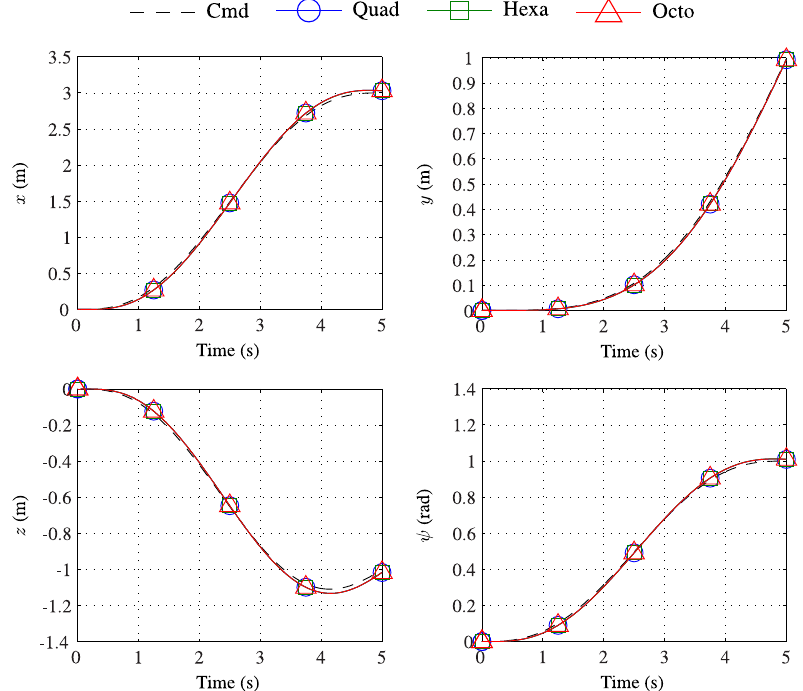
Figure 7. Dynamic response in position and heading for each multirotor when accurately tracking a commanded